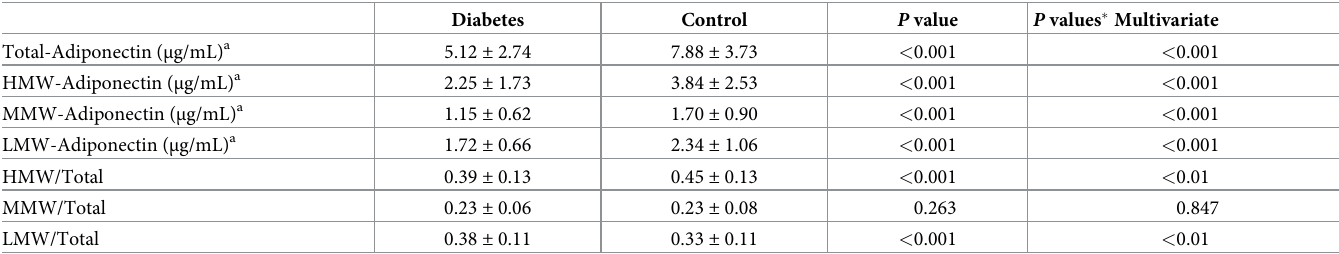
Table 4. Comparison of the various adiponectin-related parameters between diabetic subjects and control subjects in the 1 st group.